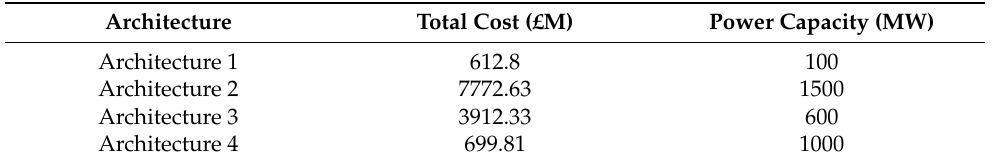
Table 14. Architectures’ total cost and power